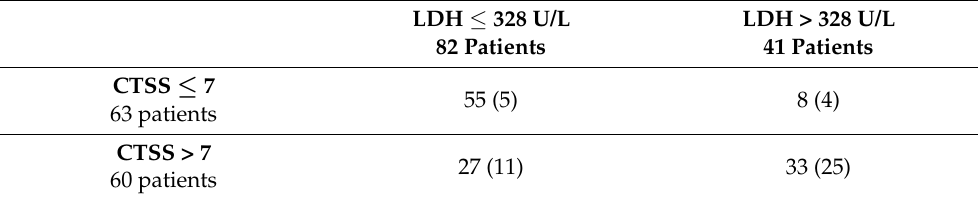
Table 4. Comparison of respiratory support prediction by CTSS and